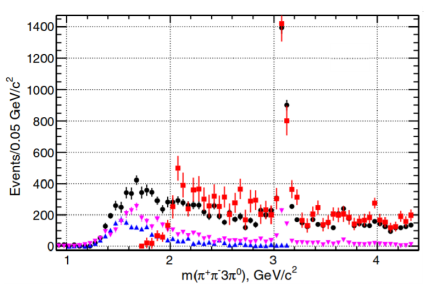
Figure 1. The measured e + e − → π + π − π 0 π 0 π 0 cross section. The uncertainties are statistical only. The low energy region ( E c . m . < 2 GeV) is dominated by ηπ + π − and ωπ 0 π 0 amplitudes, while ( ρ ± π ∓ π 0 π 0 ) dominates at higher energies.